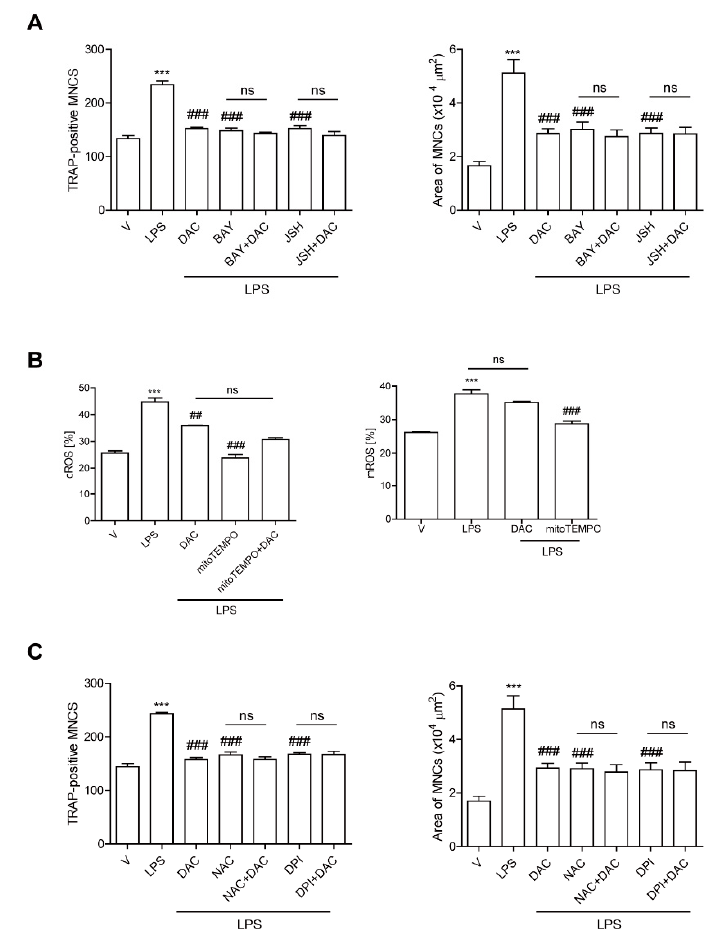
Figure 3. DAC decreases both NF-kB activation and the up-regulation of cytosolic reactive oxygen species (cROS) upon LPS stimulation in OCs. BMMs were prepared, incubated with RANKL (40 ng / mL) in the presence of M-CSF (30 ng / mL) for 40 h, and washed. Then, the cells were further incubated with BAY 11-7082 (3 µ M) or JSH-23 (10 µ M), which was chosen for 50% inhibition, and DPI (5 nM) ( A ) or NAC (3 mM) ( C ) and then stimulated with LPS (50 ng / mL) and M-CSF (30 ng / mL) in the presence or absence of DAC (7 µ M) for 48 h. Cells were fixed after 48 h, and the number of TRAP-positive MNCs in each culture was counted. Cells were stimulated with LPS (50 ng / mL) and M-CSF (30 ng / mL) in the presence or absence of DAC (7 µ M) for 24 h and 16 h to determine cytosolic ROS and mitochondrial ROS by flow cytometry using H 2 DCF-DA and mito-SOX red, respectively ( B ). *** p < 0.001 compared with RANKL-pretreated cells treated with vehicle (V). ## p < 0.01; ### p < 0.001 compared with LPS-treated cells. ns, no significant di ff erence between 2 samples. Similar results were obtained in three independent experiments.